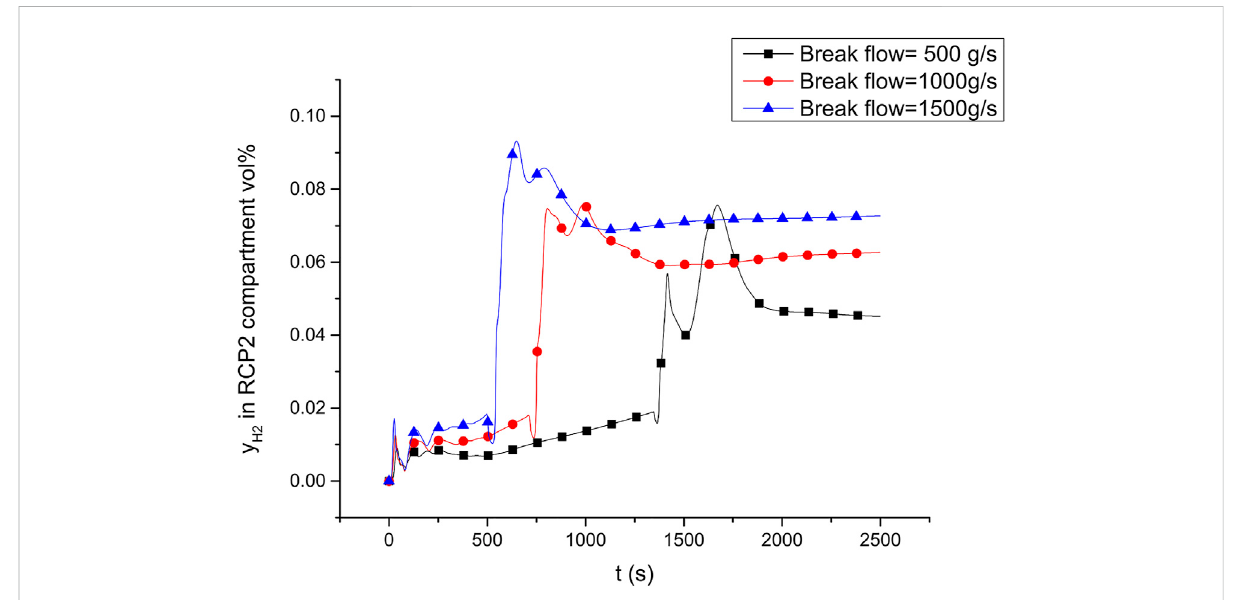
FIGURE 11 Hydrogen concentration in RCP2 compartment.